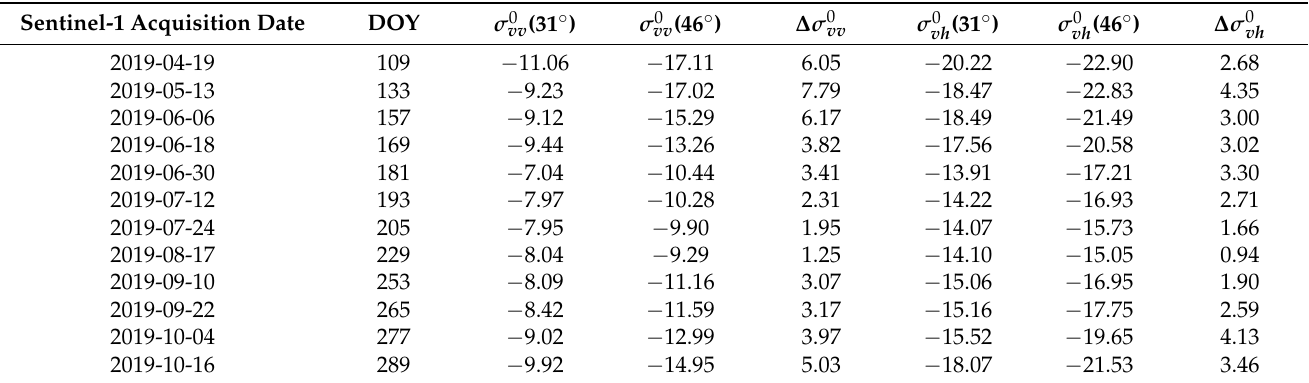
Table 1. The difference of backscattering coefficients ( ∆ σ 0 ) corresponding to incident angles of 31 ◦ and 46 ◦ in the time series Sentinel-1 C-band radar